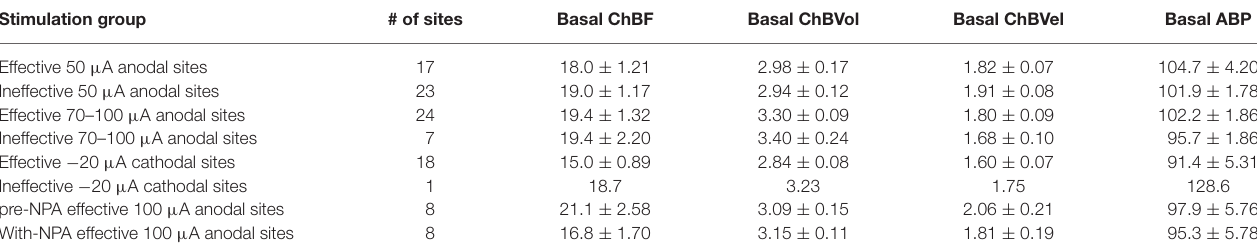
TABLE 1 | Basal choroidal parameters (ChBF, ChBVol and ChBVel) and basal arterial blood pressure (ABP) for the different sets of nucleus of the solitary tract (NTS) stimulation sites examined. Stimulation group # of sites Basal ChBF Basal ChBVol Basal ChBVel Effective 50 µ A anodal sites